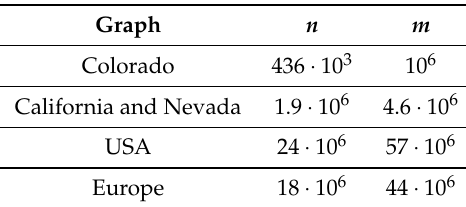
Table 1. Benchmark road